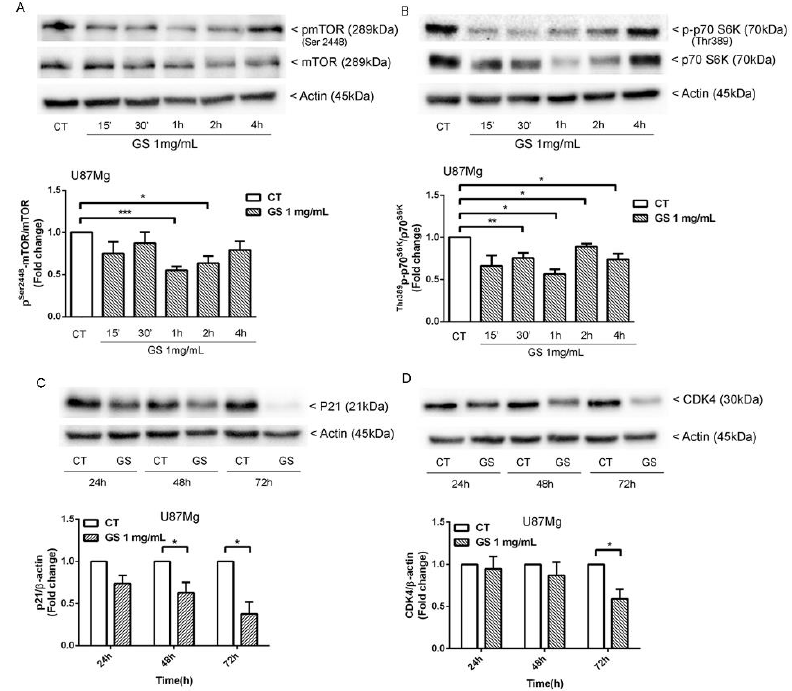
Figure 5. ( A ) In U87Mg cells, GS extract 1 mg/mL induced a significant reduction in the pospho Ser2448 - mTOR/mTOR and ( B ) p70- Thr389 S6K/p70-S6K ratio compared with cells treated with DMSO 0.3% as vehicle control. Western blot analysis of ( C ) p21 WAF1/CIP1 and ( D ) CDK4 expression after treatment of U87Mg, respectively, with GS 1 mg/mL and DMSO 0.3% as vehicle control. Densitometric analysis of protein levels represent the means ± SEM of 3 individual determinations. Data were normalised to housekeeping gene Actin and are expressed as fold change over control-treated cells. * Unpaired t -test. According to GraphPad Prism, * p -value 0.01 to 0.05 (significant), ** p -value 0.001 to 0.01 (very significant), *** p -value 0.0001 to 0.001 (Extremely significant).